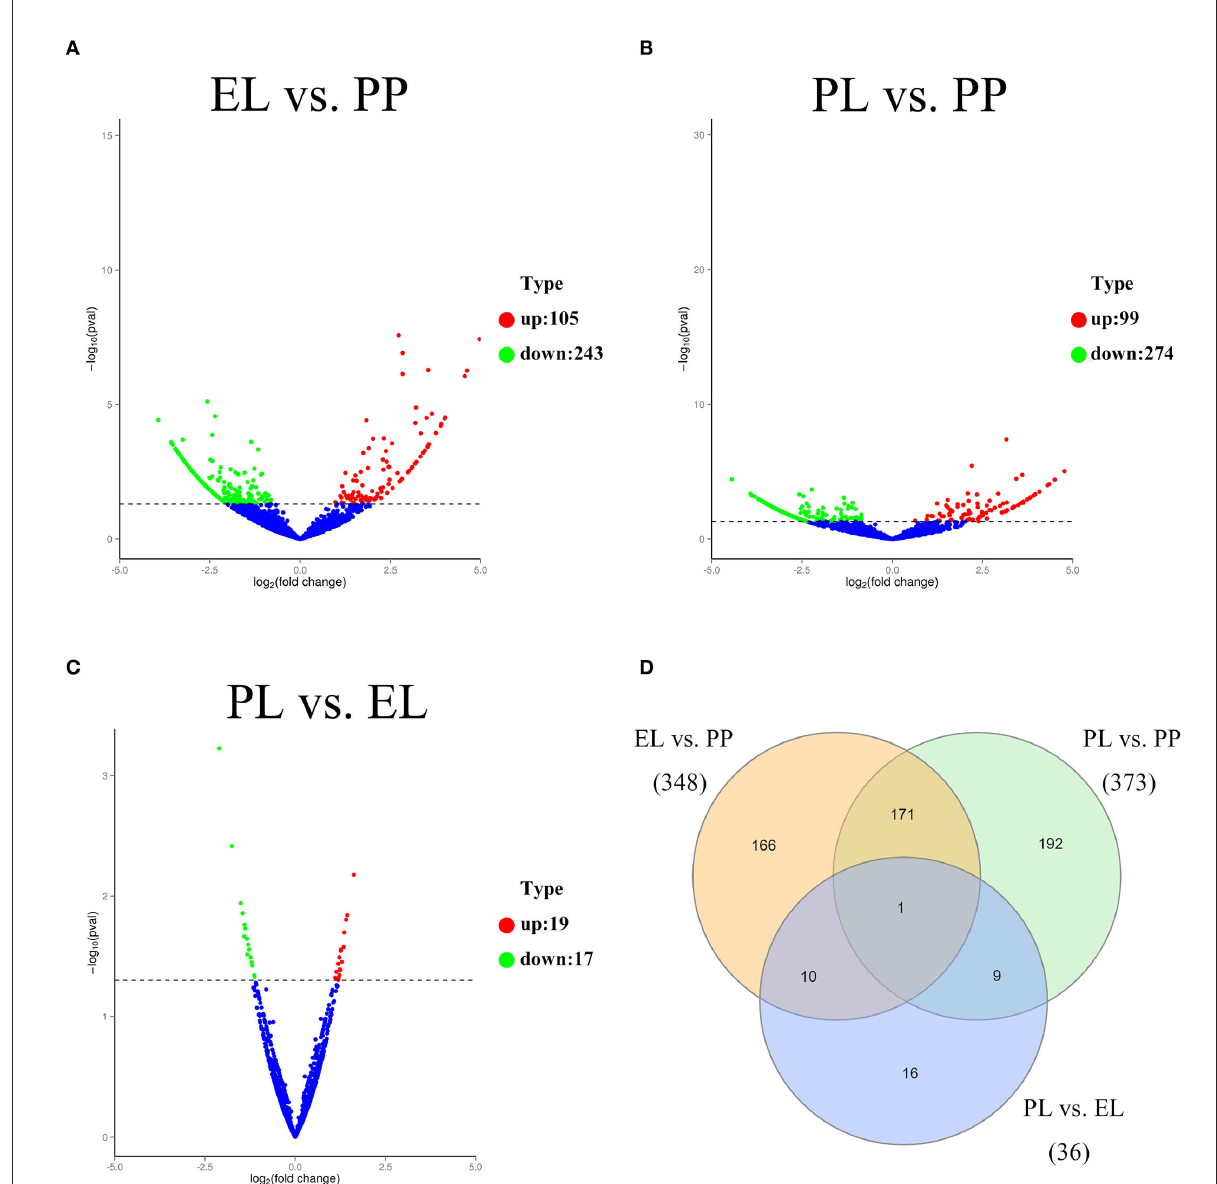
FIGURE3 The volcano plot of DE circRNAs identified in the EL vs. PP (A) , PL vs. PP (B) , and PL vs. EL comparisons (C) . A Venn diagram of DE circRNAs in all three comparisons (D) .